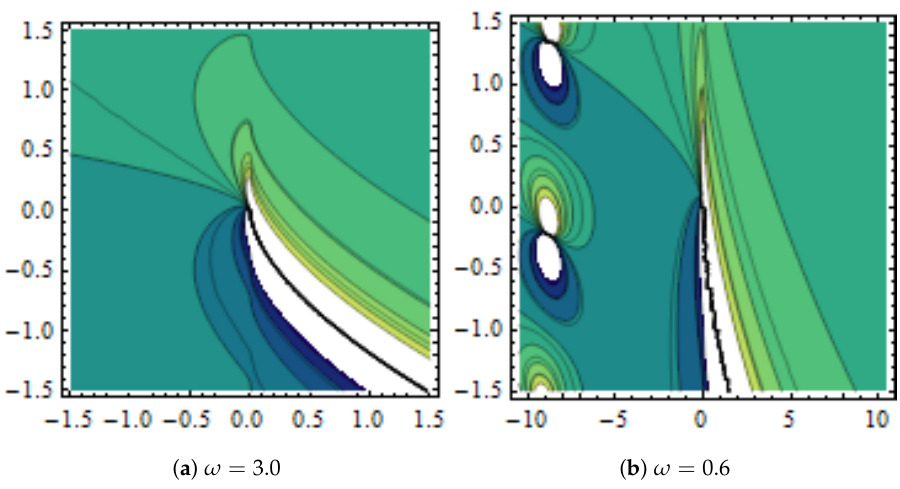
Figure 8. Graphical demonstration of solution v ( x , t ) in Equation (27) presented with β 1 = 0.3, β 2 = 0.2, β 3 = 0.5, β 4 = 0.04, ζ = 0, l 1 = 0.1, l 2 = 0.01, l 4 = 4.4, l 5 = 0.5, Q = 1.2, r 1 = 2.5, r 2 = 3.2, w 2 = 0.02, w 3 = 3.1, w 4 = 1.5, w 5 = 5 and φ = 1.4. ( a , b ) show contour plots for var- ious values of ω .